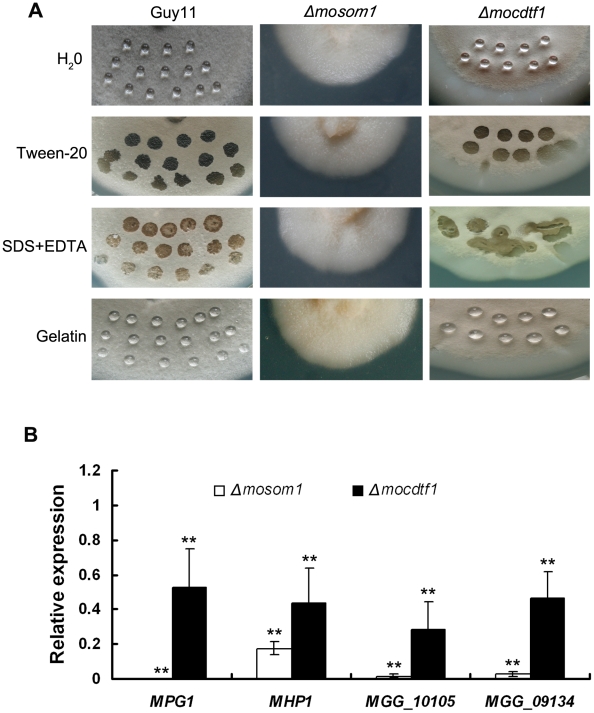
Both Δmosom1 and Δmocdtf1 mutants show an easily wettable phenotype.(A) Surface hydrophobicity of the wild type strain Guy11 and the mutants SK27 (Δmosom1) and CTK15 (Δmocdtf1) was assessed by placing a 10 µl drop water, 250 µg/ml tween20, 0.2% SDS+50 mM EDTA, and 0.2% gelatin on the 7-day-old cultures, respectively. Drops of water and 0.2% gelatin remained on the cultures of Guy11 and the old mycelium of the mutant CTK15, while the others were soaked into colonies. The photographs were taken after 12 h incubation. (B) Expression of the genes coding hydrophobins in the Δmosom1 (SK27) and Δmocdtf1 (CTK15) mutants measured by quantitative reverse-transcription polymerase chain reaction (qRT-PCR). Error bars represent the standard deviation. Asterisks indicate significant difference at P = 0.01.